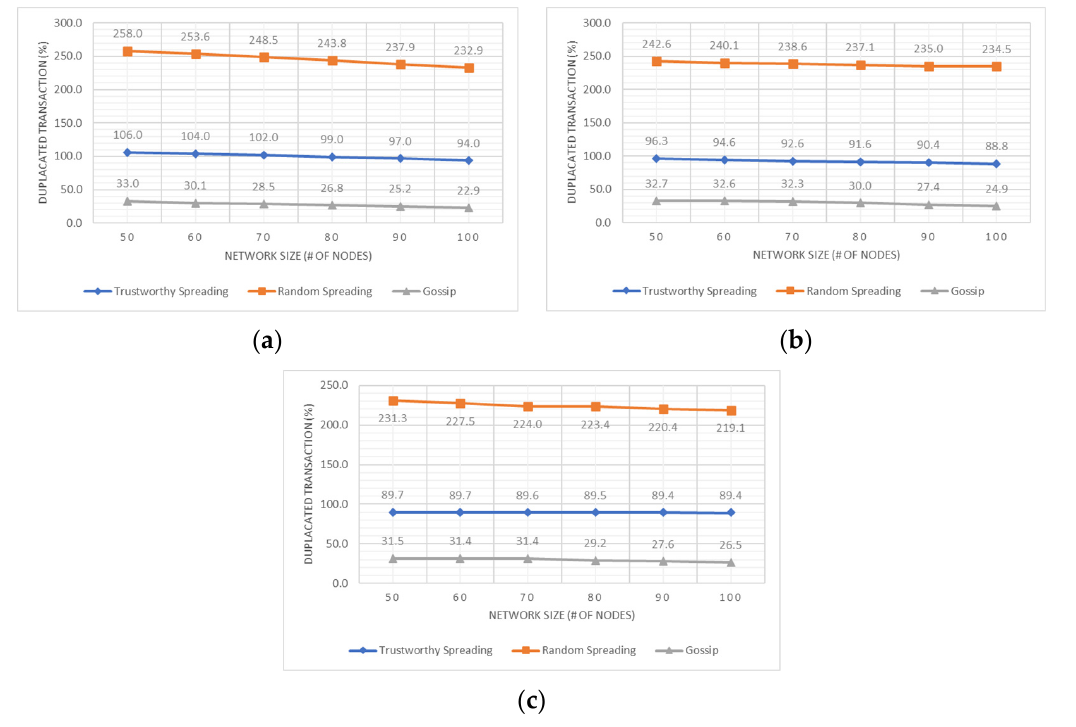
Figure 8. Duplicated transaction rate. ( a ) Single malicious node; ( b ) Double malicious node; ( c ) Triple malicious